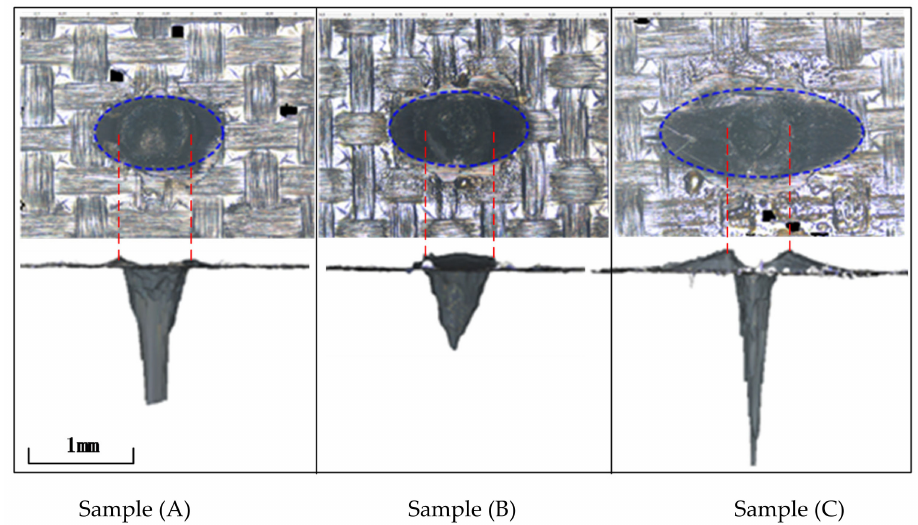
Figure 6. Morphology of CFRP measured by a 3D surface measuring instrument. Sample ( A ) N = 1, I = 990 J/cm 2 , τ p = 1 ms; Sample ( B ) N = 5, I = 103 J/cm 2 , τ p = 1 ms; Sample ( C ) N = 10, I = 149 J/cm 2 , τ p = 1 ms.